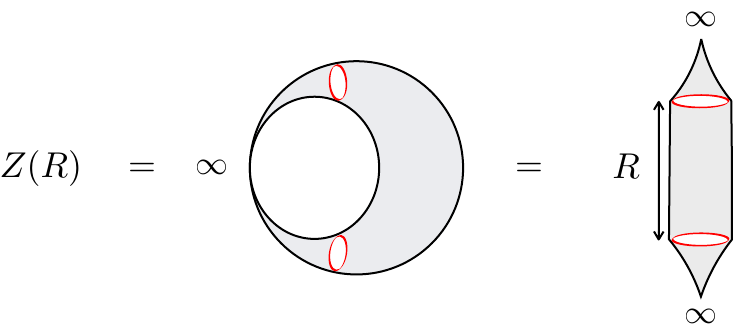
Figure 5 . We identify the wave function normalization factor Z with the excited state partition function. The latter is computed for a pinched torus of length R (cid:29) 1 and period L 1 , with the pinching being such that only the Bethe state of interest can